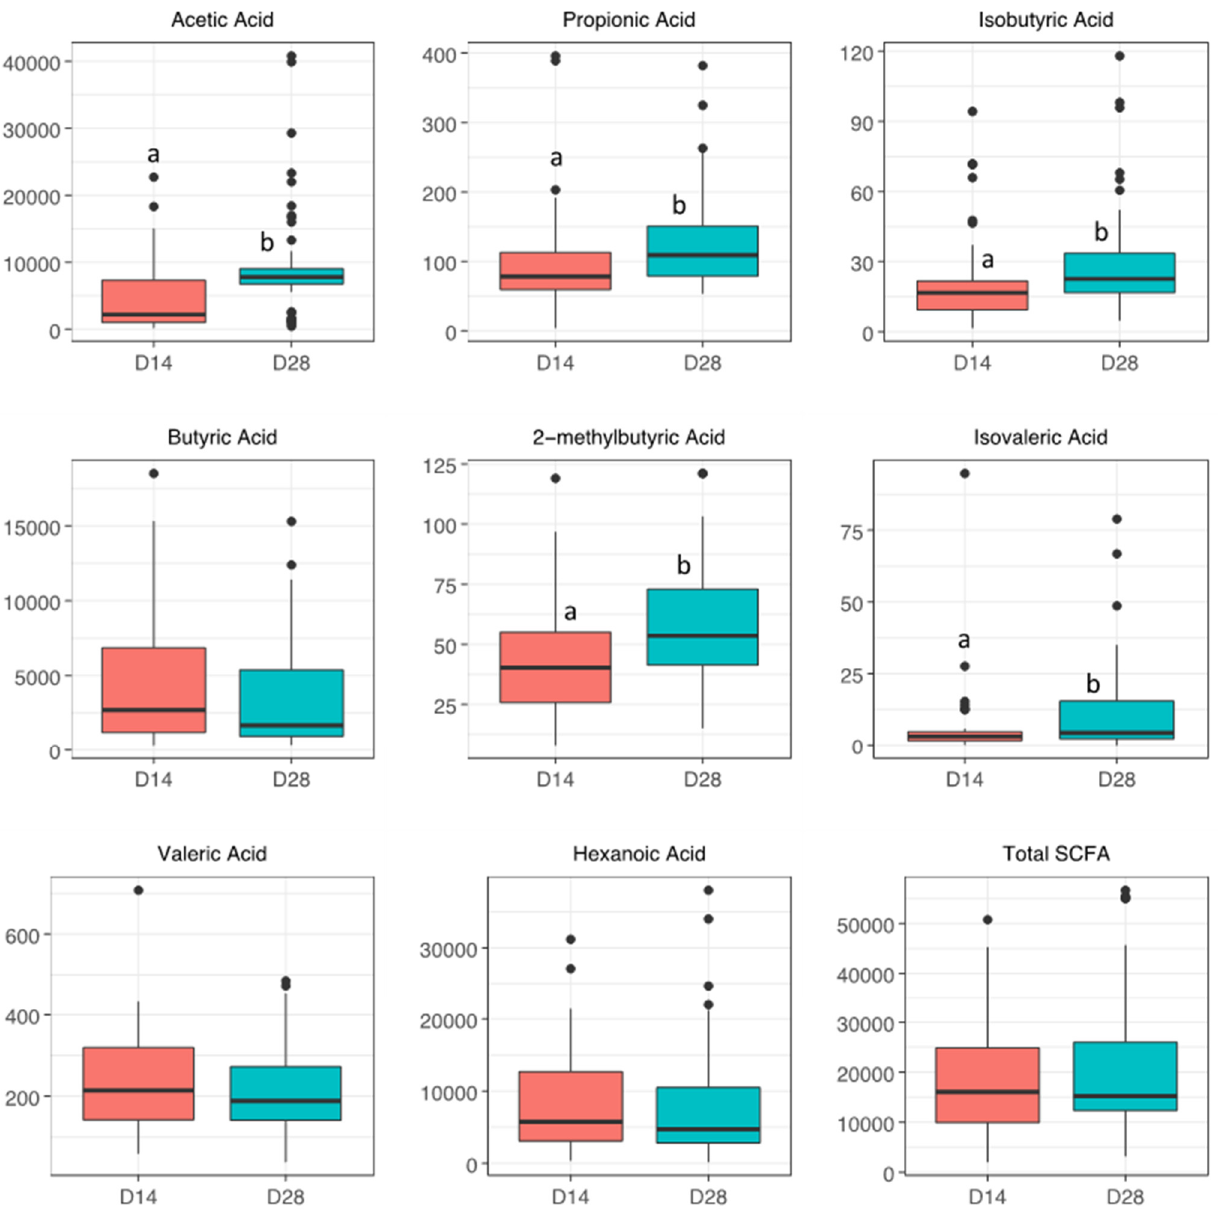
Figure 1. Short-chain fatty acid levels (ng/mL) in breastmilk samples on days 14 and 28. Boxplots show SCFA levels on days 14 and day 28. Wilcoxon tests were performed to test for statistical significance. Labeled points without a common letter are significantly different ( p < 0.05).